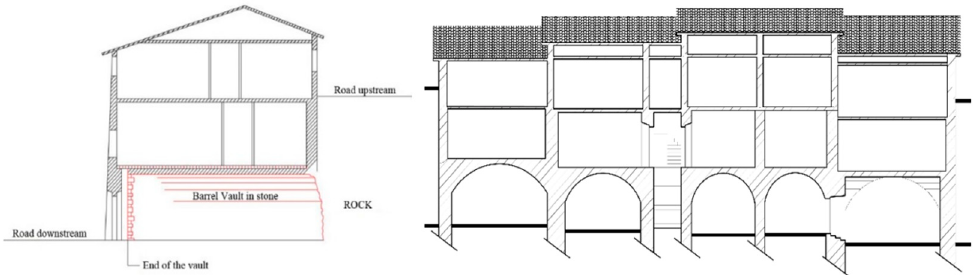
Figure 3. Schematic representation of a typical structural aggregate (SA25 is shown) in Campi Alto di Norcia.